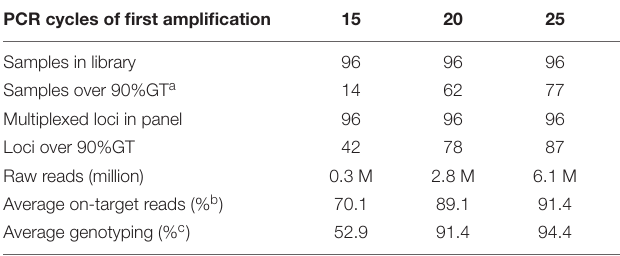
TABLE 2 | Comparison of genotyping rates with different numbers of PCR cycles for GT-seq library construction. PCR cycles of first amplification